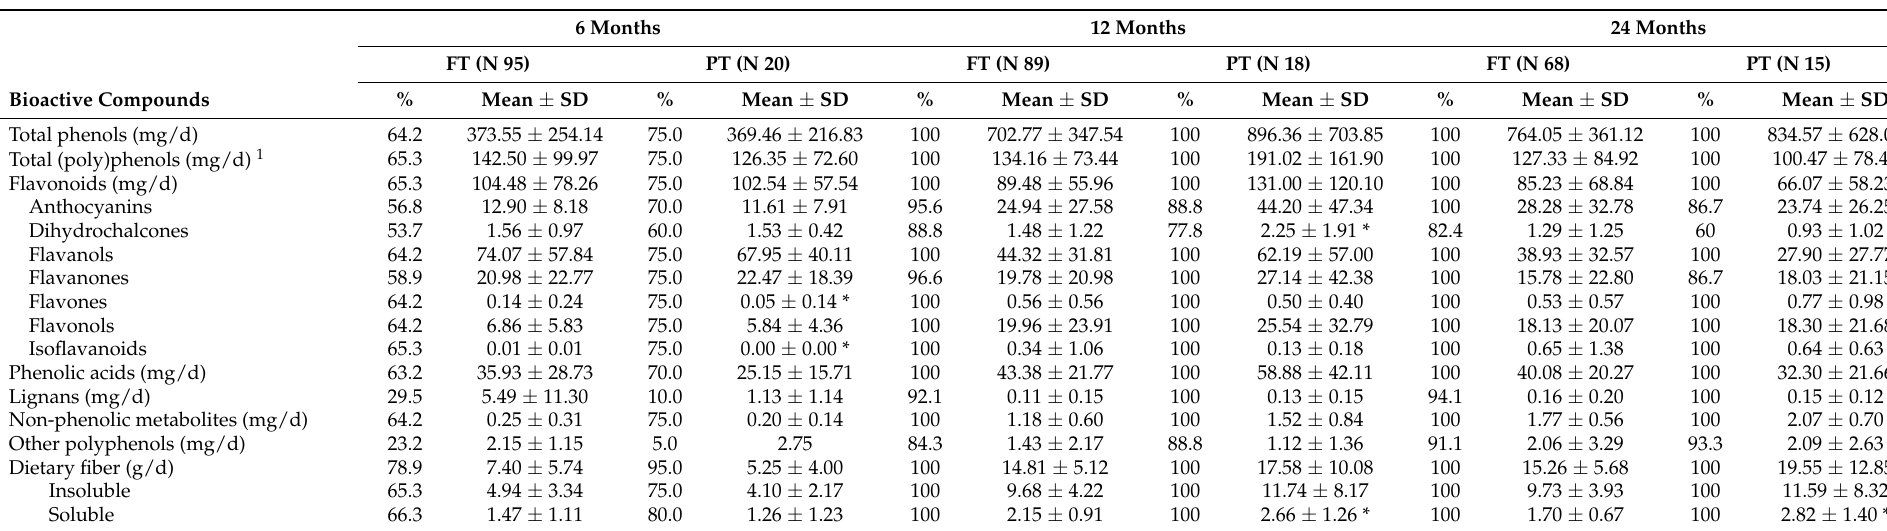
Table 4. Differences in the intake of bioactive compounds (phenols and fibers) between Full-term (FT) and Preterm (PT) from 6 to 24